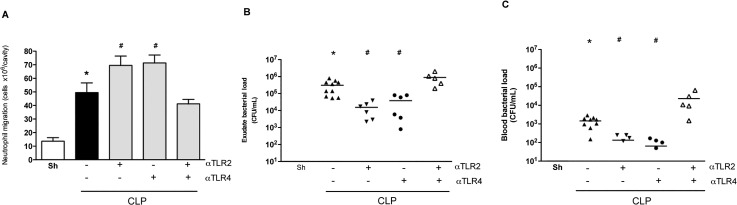
Blockade of either TLR2 or TLR4 improves inflammatory and infection indices in polymicrobial sepsis.Analysis of parameters of mice pre-treated (45 minutes before the CLP procedure) with individual anti-TLR2 or anti-TLR4 antibodies showed an increased neutrophil migration to the peritoneal cavity (A) and a decreased number of bacteria in peritoneum (B) and serum (C) 6 hours after sepsis compared to negative isotype IgG antibody treatment (black bar). The combined treatment with both anti-TLR2 and anti-TLR4 showed a similar inflammatory response compared to the negative control isotype IgG treated-group (CLP). * p<0.05 between the CLP and Sham groups. # p<0.05 between individual antibody treatments and negative control isotype IgG treated-group. Antibody dose (1 mg/animal). Horizontal bars in Fig 2A/2B represent median value. Used 6 animals/group, except isotype IgG antibody treated group (n = 10). Missing points in Figs reflect number of bacteria below detection limit.